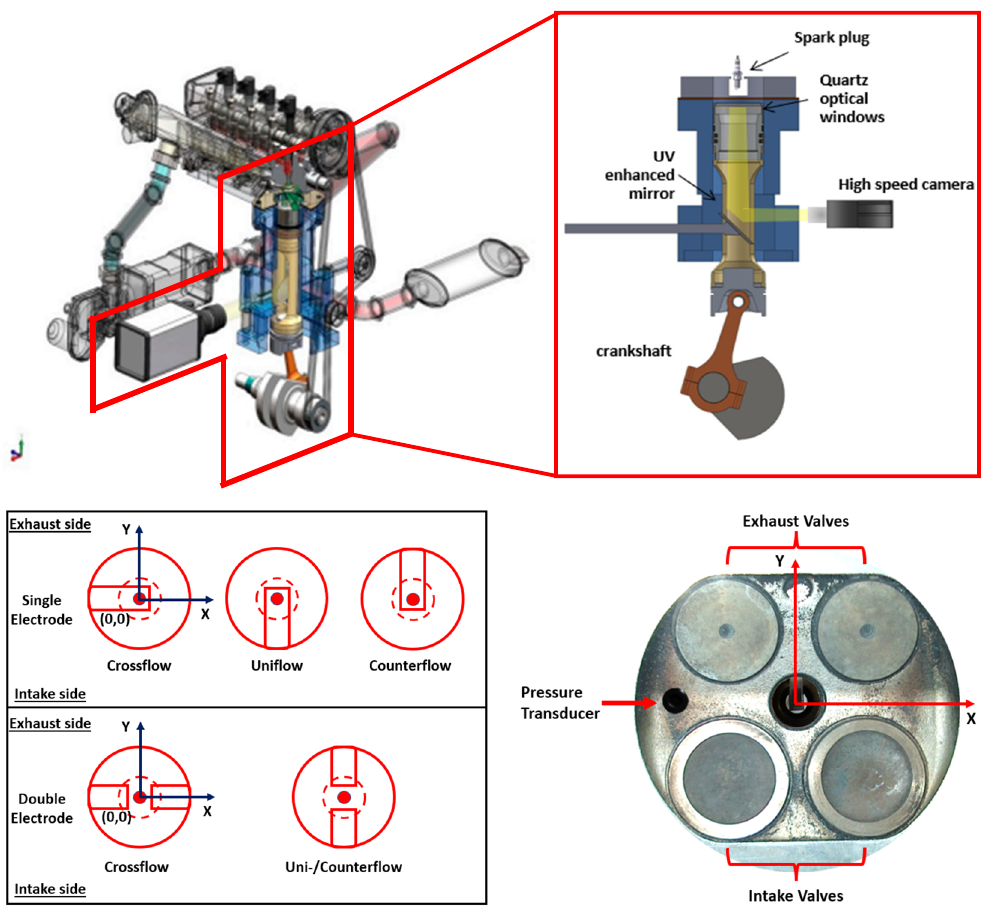
Figure 1. Experimental setup ( top left ), detailed sketch of the elongated piston ( top right ), spark plug orientations investigated ( bottom left ), and detailed sketch for the single electrode spark plug in counterflow configuration ( bottom right